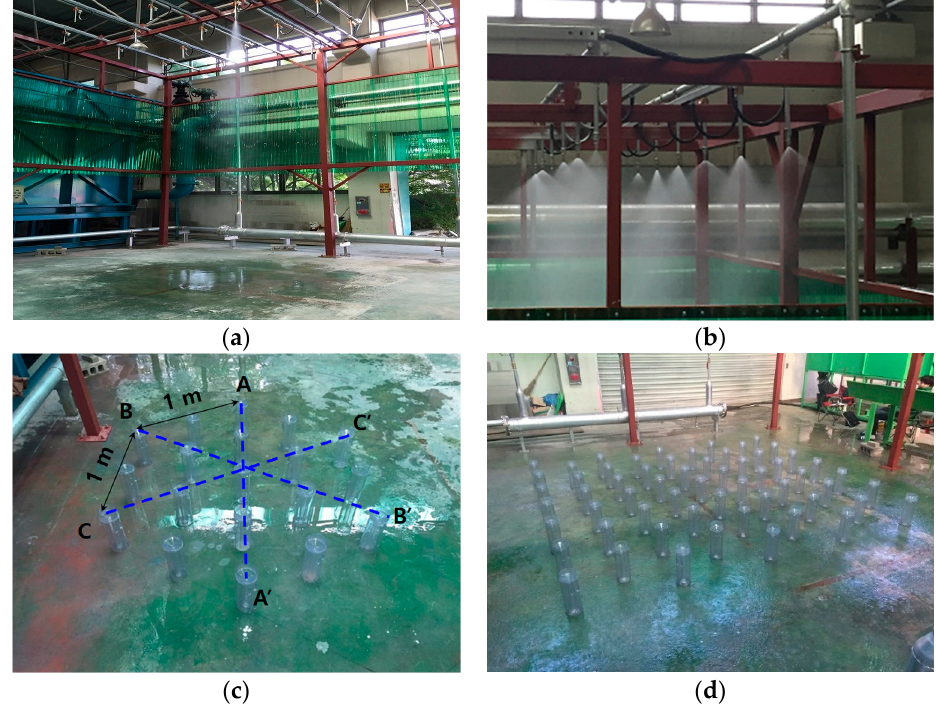
Figure 2. Arrangements of rain gauges for the uniformity tests: ( a ) operation for a single nozzle test; ( b ) operation for a total nozzle test; ( c ) single nozzle test; ( d ) total nozzle test.